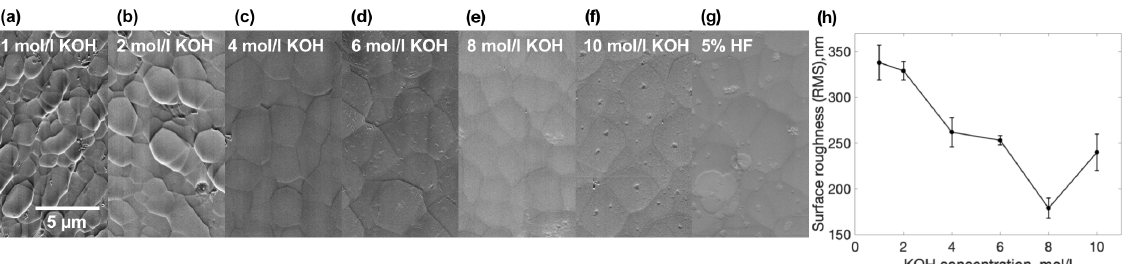
Figure 4. Etching rate evolution over time. ( a ) etching rate after 2 h of etching, ( b ) after 4 h, ( c ) after 8 h, and ( d ) after 12 h.